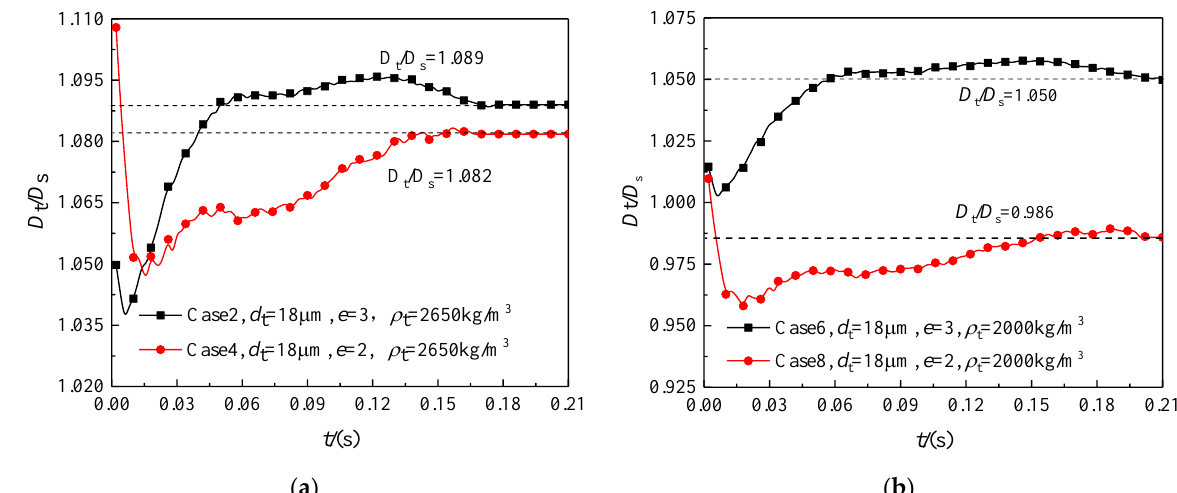
Figure 11. Variations of displacement ratio D t / D s between tracer and slurry particle with respect to time t under conditions of e 0 = 2, 3 and d t = 18 μm: ( a ) ρ t = 2650 kg/m 3 ; ( b ) ρ t = 2000 kg/m 3 .